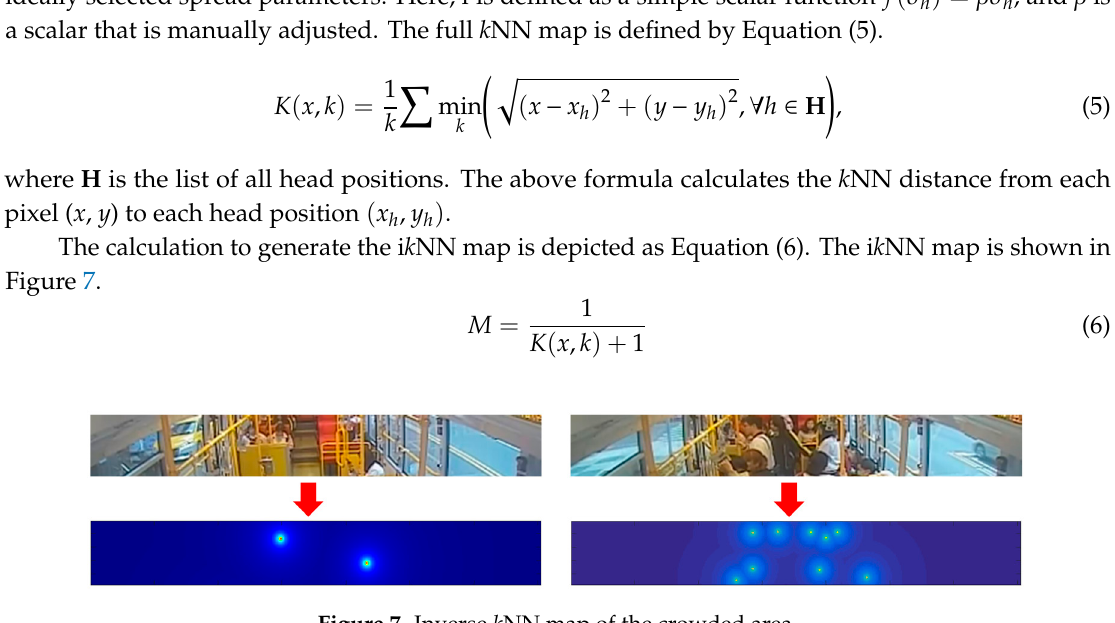
Figure 7. Inverse k NN map of the crowded area.